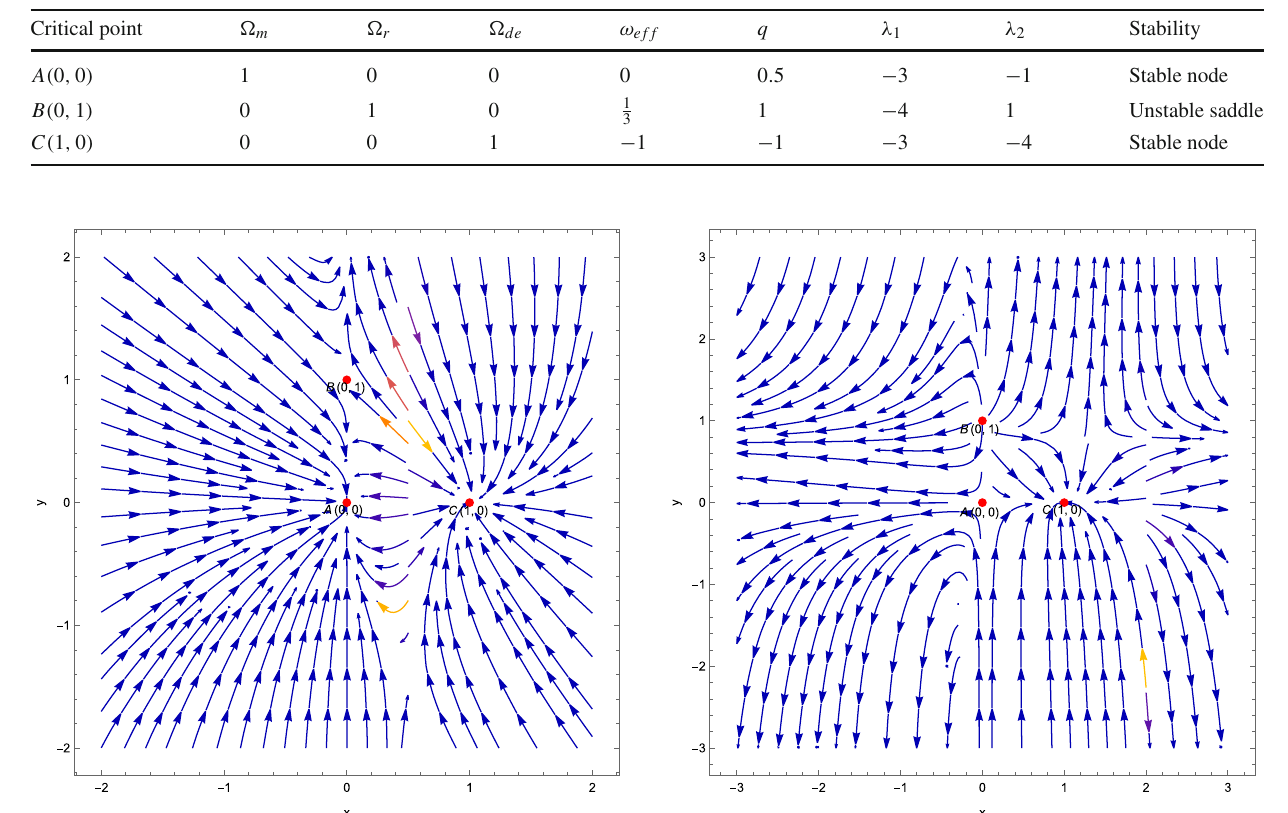
Table 2 Eigen values and critical points for the dynamical system corresponding to Model-I